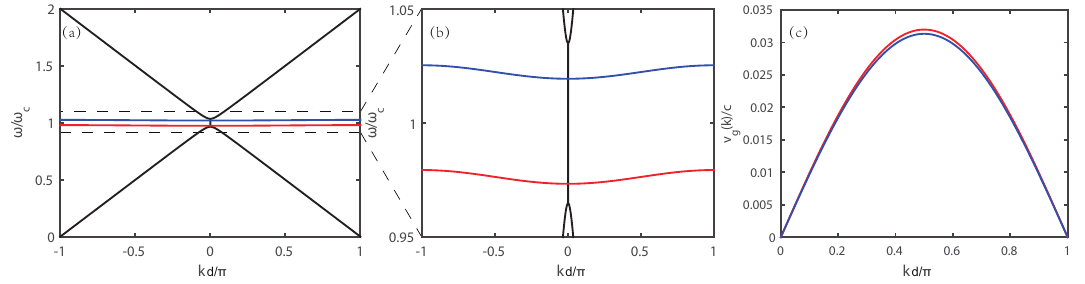
Figure 5. ( a , b ) dispersion diagrams of the CLC (black curve) and of the mini-bands formed in the MDL-CLC (blue and red curves) for RCP light in the first Brillouin zone; the quantity ω c is the center frequency of the PBG; ( c ) group velocity corresponding to the